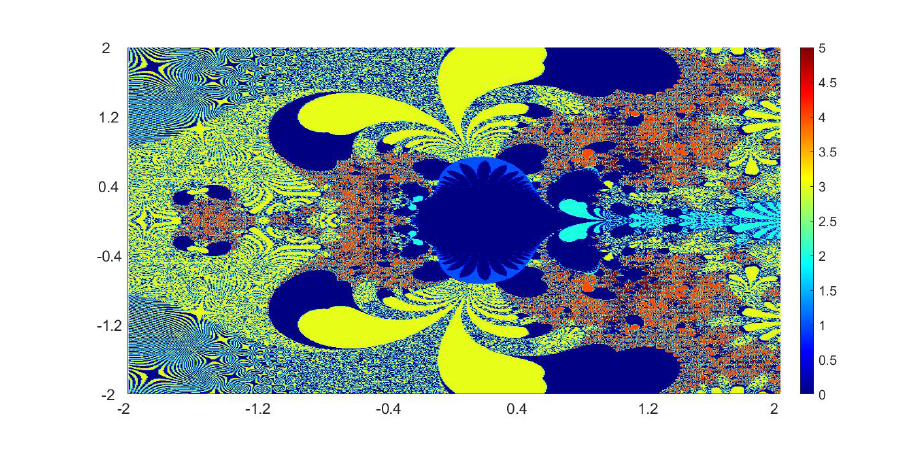
Figure 18. Example 5(b).